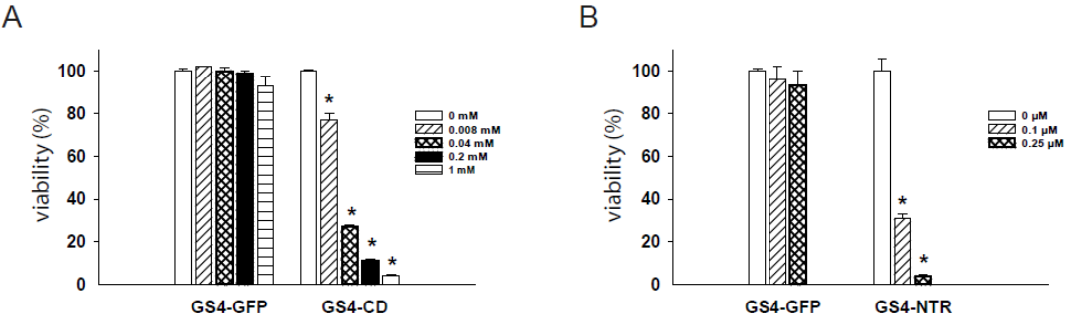
Figure 3. In vitro cytotoxicity achieved by GALV-based RRV plus prodrug treatment. ( A ) GS4-CD- and GS4-GFP-transduced RG-2 cells were exposed to 5-FC ranging from 0 to 1 mM, and cell viability was determined 3 days later by MTS assay. ( B ) GS4-NTR- and GS4-GFP-transduced RG-2 cells were exposed to CB1954 ranging from 0 to 0.25 μM, and cell viability was determined 3 days later by MTS assay. *, p < 0.005.